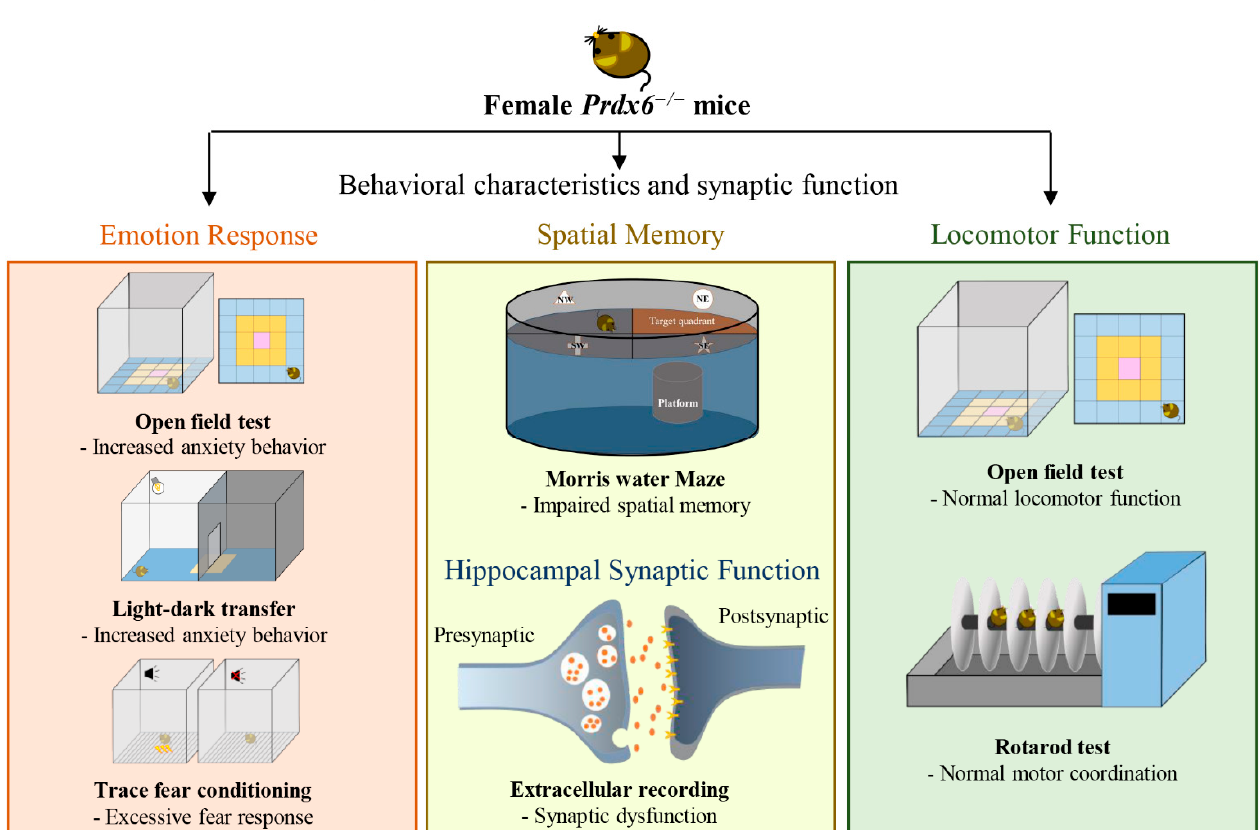
Figure 7. Graphical summary for the behavioral and synaptic phenotypes of female Prdx6 − / − mice. The female Prdx6 − / − mice exhibited high emotional responses, including anxiety-like behavior and enhanced fear expression (orange box). These mutant mice also displayed impaired spatial memory and hippocampal synaptic function (yellow box). Normal locomotion and motor coordination were also observed in female Prdx6 − / − mice (green box).